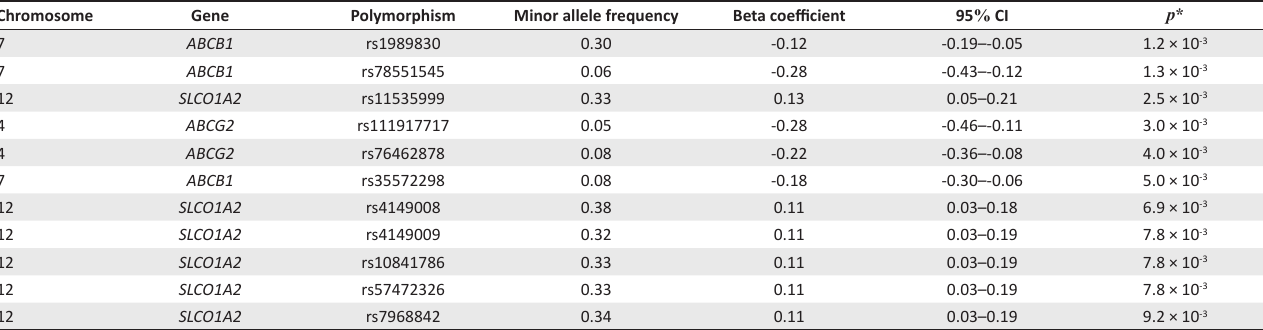
TABLE 2: Genetic associations with detectable log10-transformed cerebrospinal fluid-to-plasma tenofovir concentrations in 43 black South African adults. Chromosome Gene